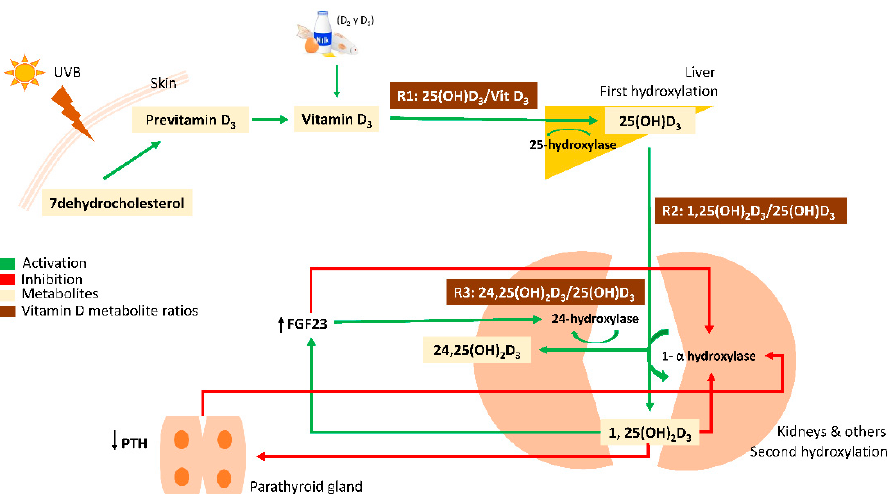
Figure 1. Vitamin D metabolism. Previtamin D 3 synthesis takes place in the skin by the action of UVB radiation. It undergoes a first hydroxylation in the liver by the enzyme 25-hydroxylase ( CYP2R1 ), forming 25(OH)D 3 . Subsequently, 25(OH)D 3 is hydroxylated to the bioactive 1,25(OH) 2 D 3 by the enzyme 1 α -hydroxylase ( CYP27B1 ), predominantly in the kidneys. Vitamin D catabolism is mainly driven by the enzyme 24-hydroxylase ( CYP24A1 ), which metabolizes 25(OH)D 3 to 24,25(OH) 2 D 3. Vitamin D homeostasis depends on 1,25(OH) 2 D 3 concentration, which can decrease its own production by directly inhibiting the expression of 1 α -hydroxylase or indirectly, by decreasing the synthesis of the parathyroid hormone ( ↓ PTH) or increasing the expression of the phosphaturic factor, fibroblast growth factor 23 ( ↑ FGF23). VMR: Vitamin D Metabolite Ratio.